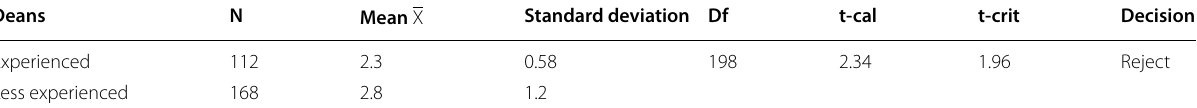
Table 4 Test for significant difference in experienced and less experienced university Deans’ awareness of the need for quality assurance in the school setting